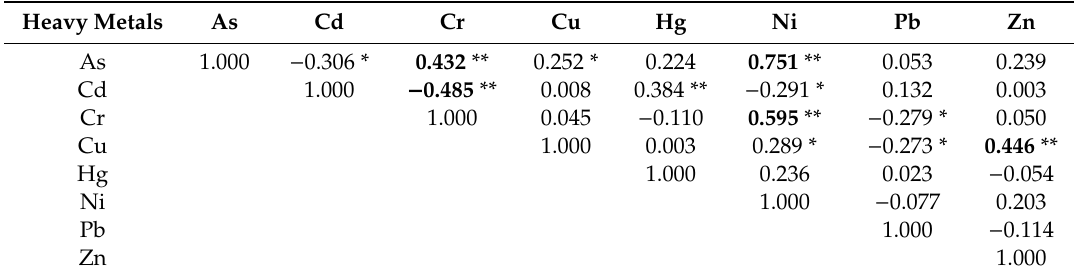
Table 3. Correlation matrix for r values of heavy metals in soil and sediment from the Huixian wetland. Heavy Metals